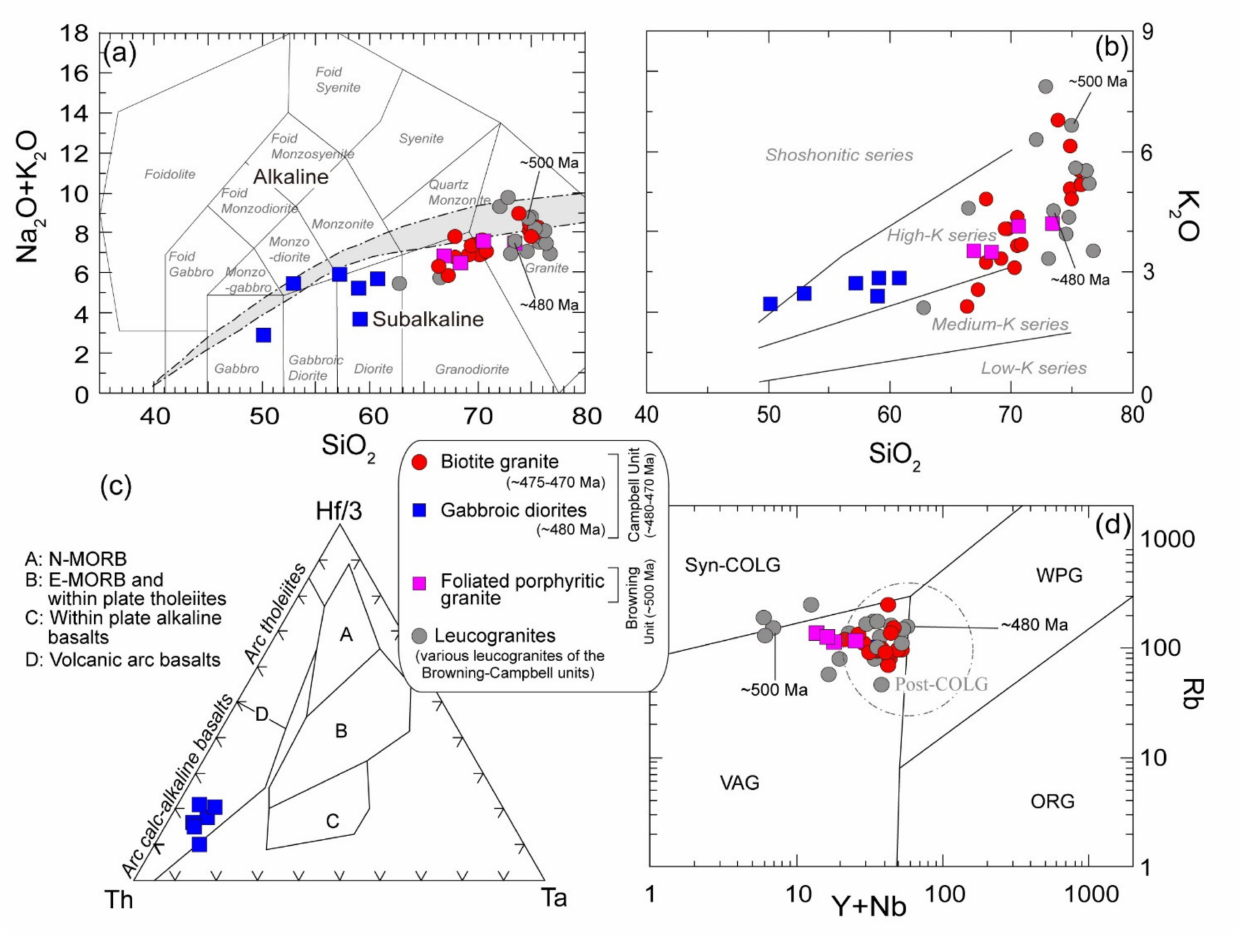
Figure 7. Classification plots showing BIU–CIU rocks in the TNIC including the ( a ) total alkali vs. silica (TAS) diagram (after [32]) with alkaline, transitional, and subalkaline subdivisions (after [38–41]) and ( b ) K 2 O vs. SiO 2 diagram (after [24]) and tectonic discriminations in ( c ) Hf/3-Th-Ta ternary diagram (after [42]) and ( d ) Rb vs. Y+Nb diagram (after [43]). Major element concentrations in ( a , b ) were recalculated to 100 wt.% on a volatile-free basis. N-MORB: normal-mid-oceanic ridge basalt; E-MORB: enriched-MORB; Syn-COLG: syn-collisional granites; Post-COLG: post-collisional granites; VAG: volcanic arc granites; WPG: within plate granites; ORG: oceanic ridge